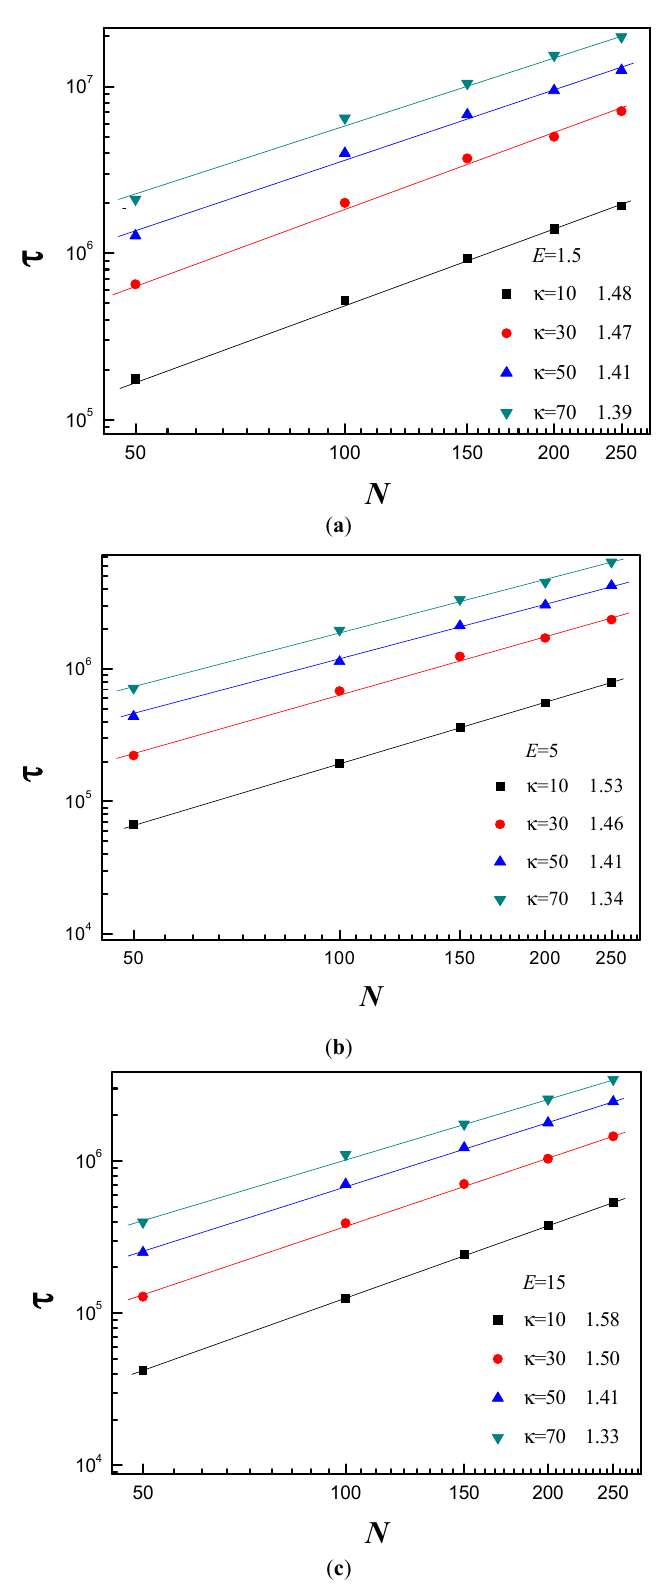
Figure 5. The average translocation time τ as a function of chain length N for the different κ at: ( a ) E = 1.5; ( b ) E = 5; and ( c ) E = 15.